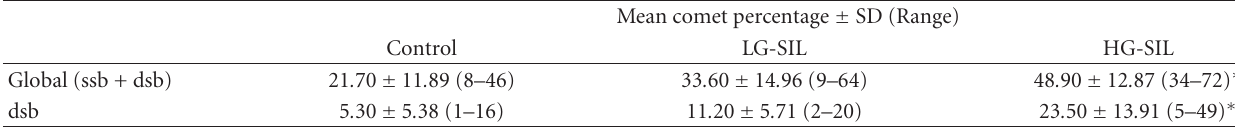
Table 1: DNA damage evaluated in alkaline conditions (ssb + dsb) and in neutral conditions (dsb) in women with LG-SIL and HG-SIL and in control women.